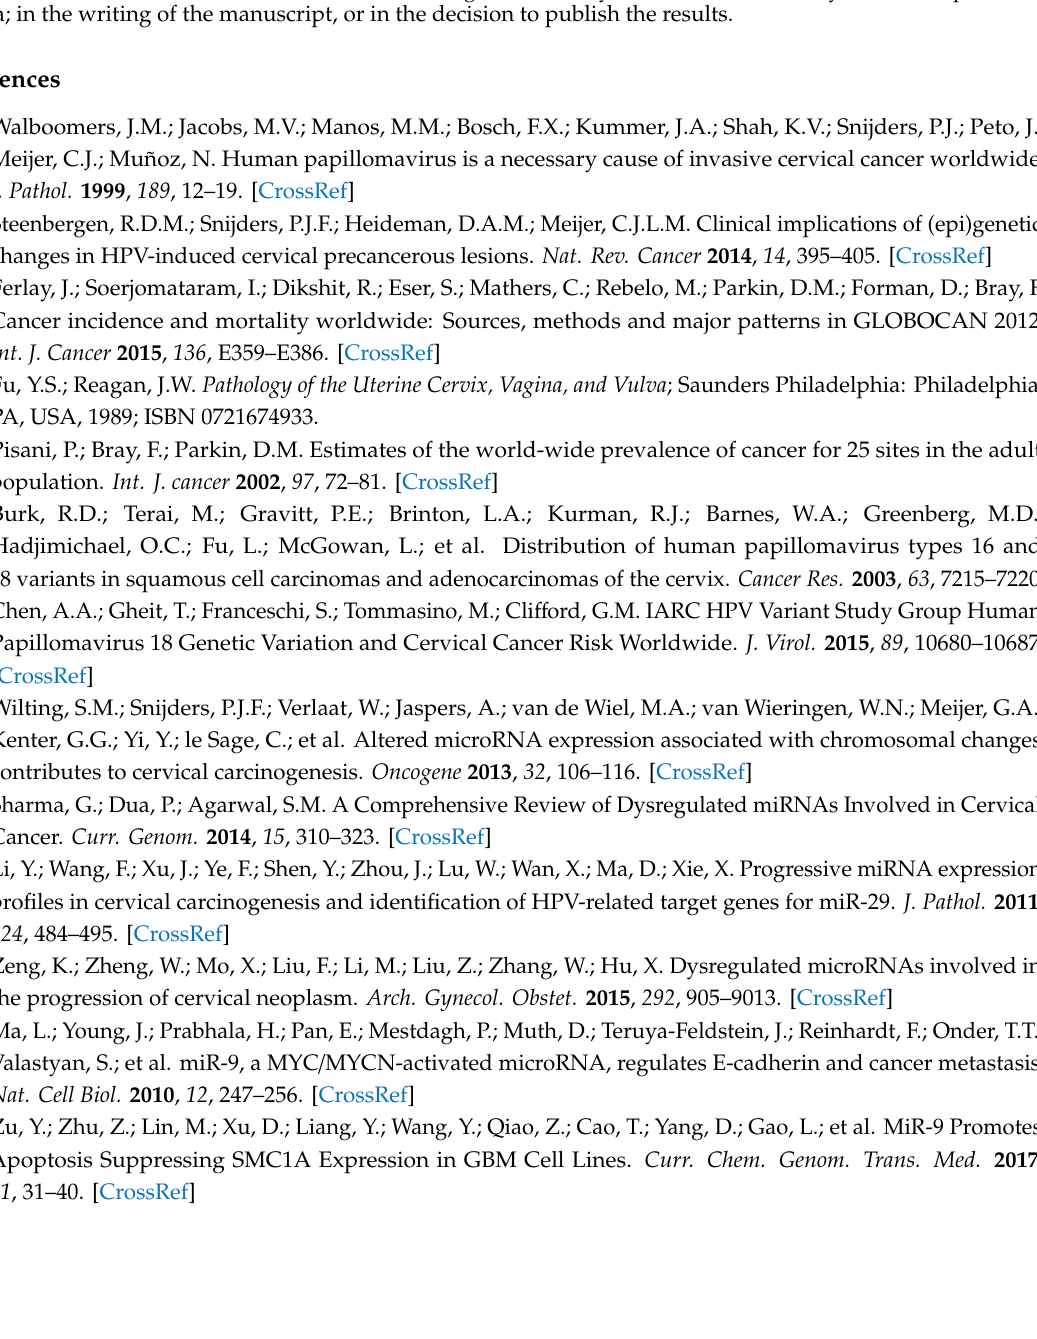
Table S1: Primer sequences; Table S2: Expression of miR-9-5p in whole miRNome sequencing data from the TCGA depository [32]; Table S3: Correlation of miR-9-5p expression with expression of TWIST1, CDH1, and CDH2; Figure S1: E ff ect of miR-9-5p on IL6 and FOXO3 in cervical cancer cell